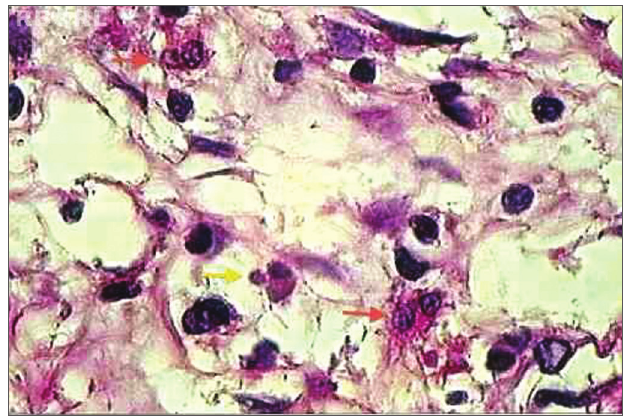
Figura 1. Histopatologia de pólipo nasossinusal eosinofílico (grupo controle) incubado por 12 horas (H&E 1000x).